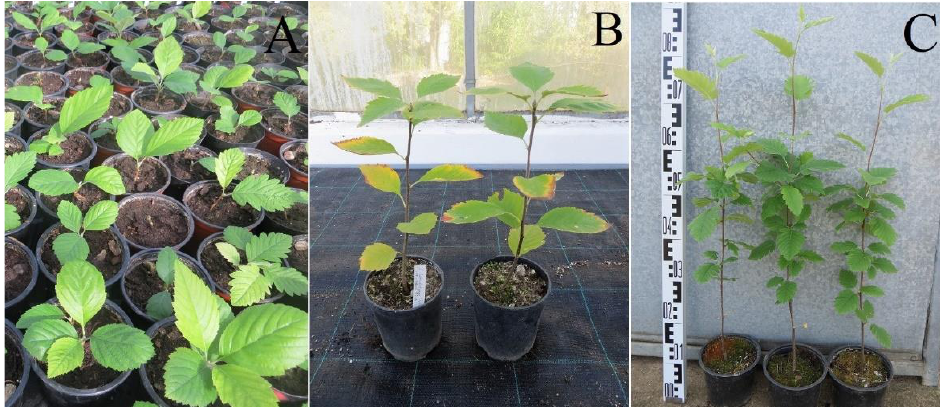
Figure 4. Acclimatization and development of rooted plants of Sorbus species. ( A ) 1-year-old plants ( S . × abscondita and S. omissa ). ( B ) 2-year-old plants ( S . × kitaibeliana ). ( C ) 3-year-old plants ( S . × abscondita ).